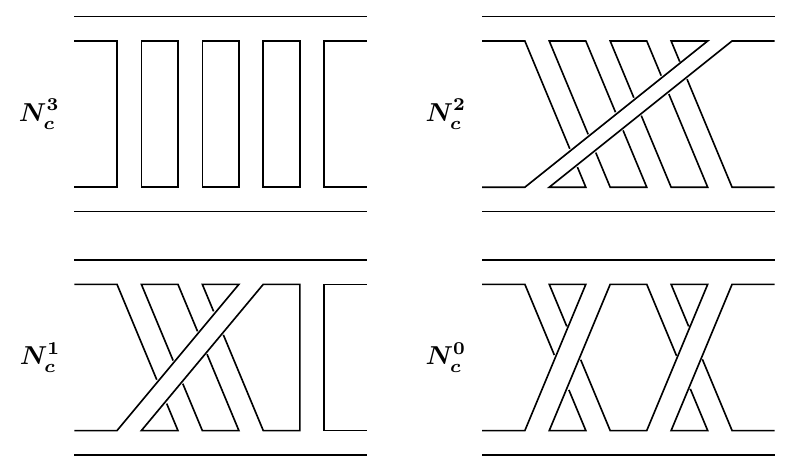
Figure 8 . Open two-points at ‘ = 4. We (cid:12)nd (cid:28) = (1)(2)(3)(4) and (1234) (top left and right), (123)(4) and (12)(34) (bottom left and right); R ab